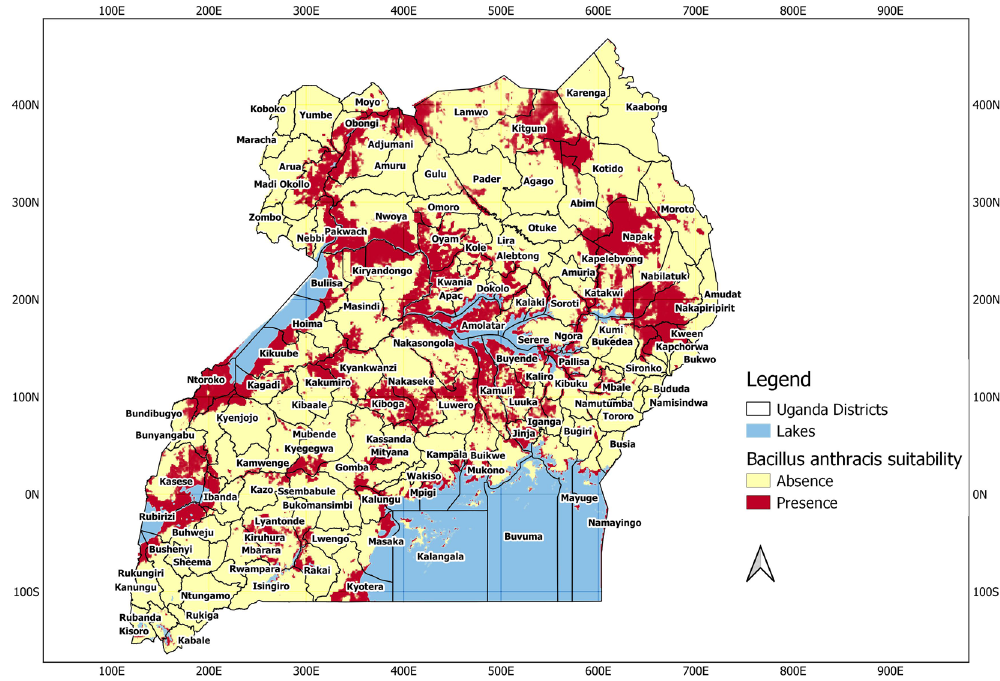
Figure 5. A binary map of the posterior predictive mean of the probability of B. anthracis suitability across Uganda using the threshold for maximum sensitivity and specificity (0.52). Prediction maps were developed using the Quantum Geographic Information System software (QGIS). URL: https:// qgis. osgeo. org